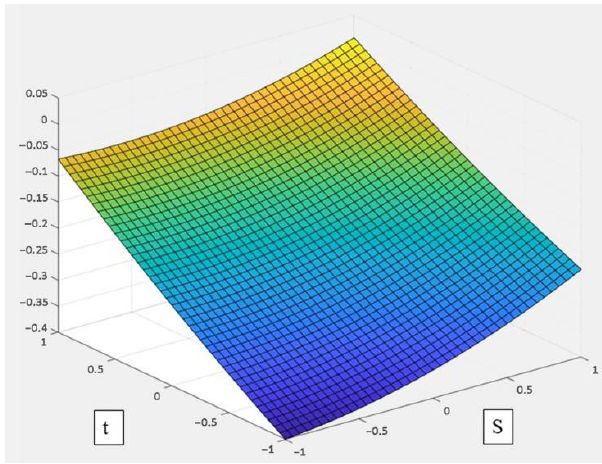
Figure 14. The surface of the change in criterion logarithm value from the cutting depth and feed encoded values at a speed of V = 17 m/min.